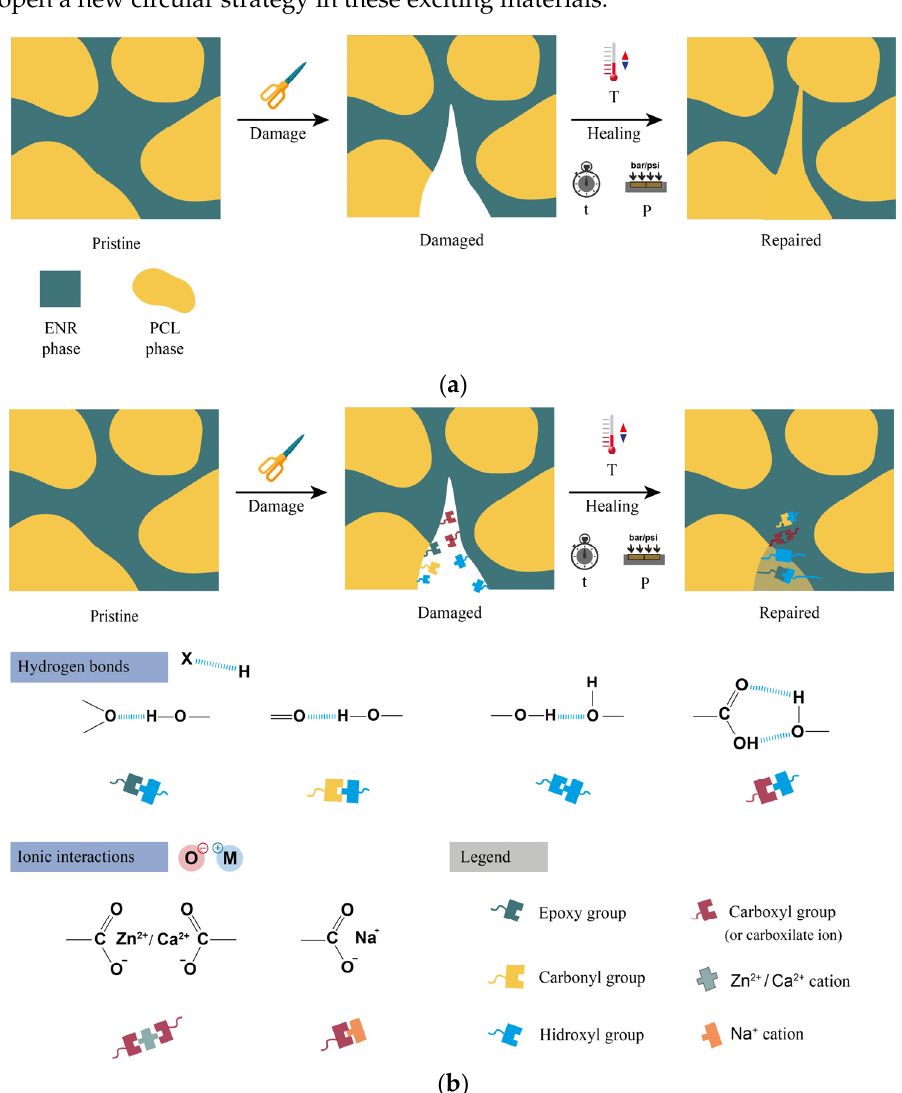
Figure 13. Scheme of self-healing: ( a ) extrinsic and ( b ) intrinsic mechanisms.